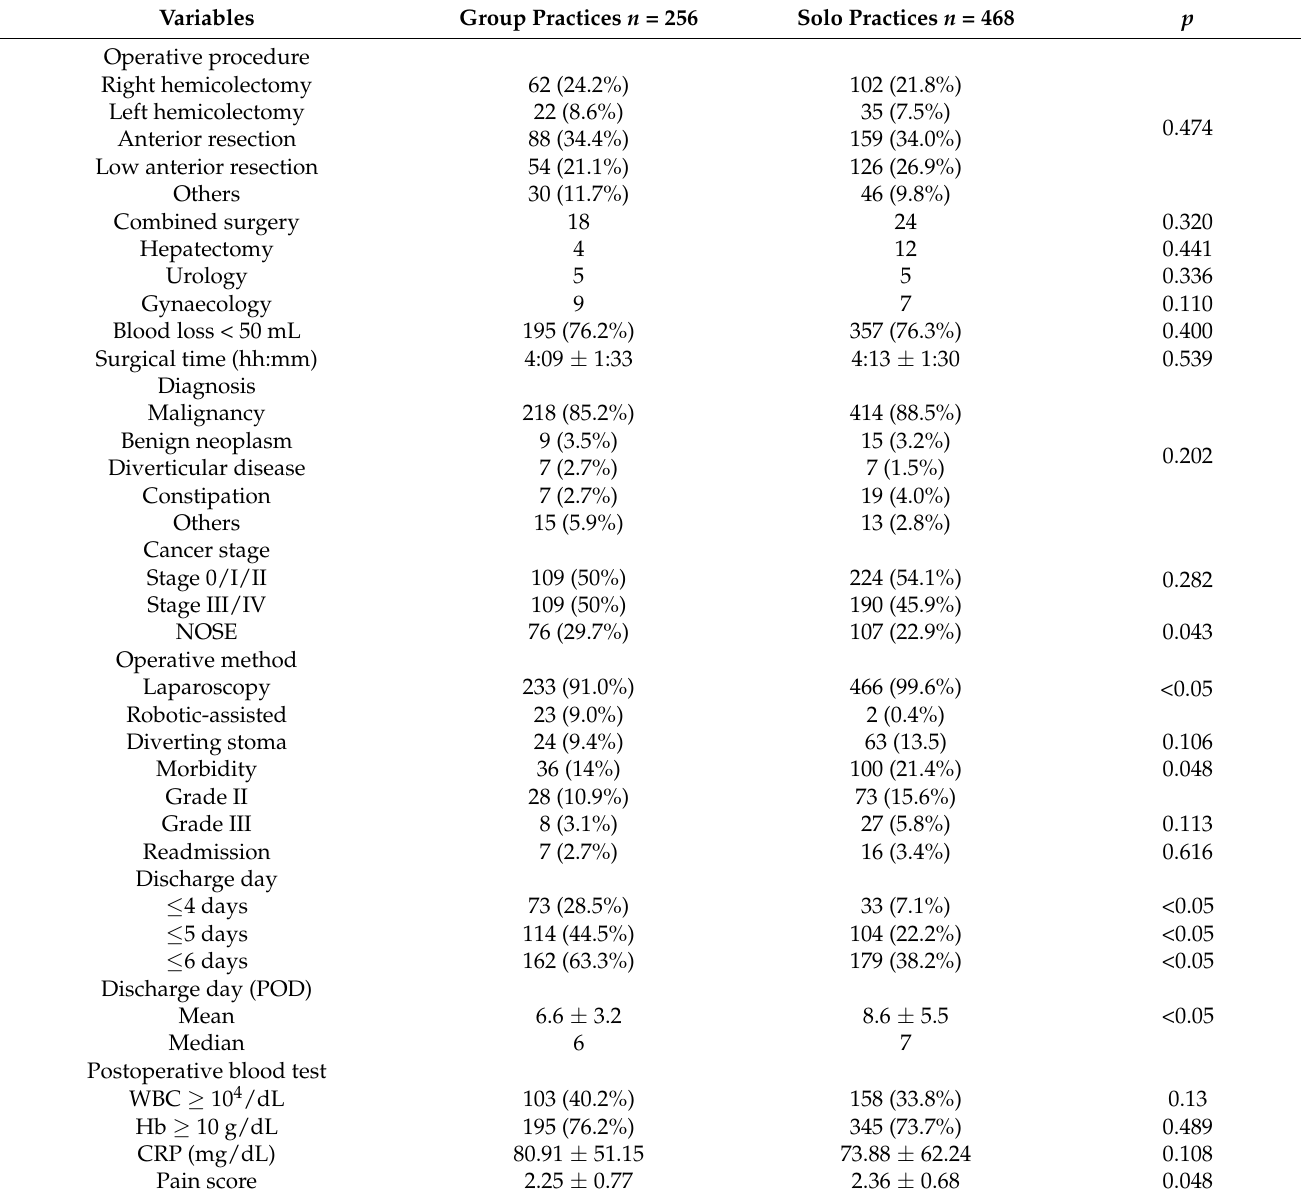
Table 2. Operative and Postoperative